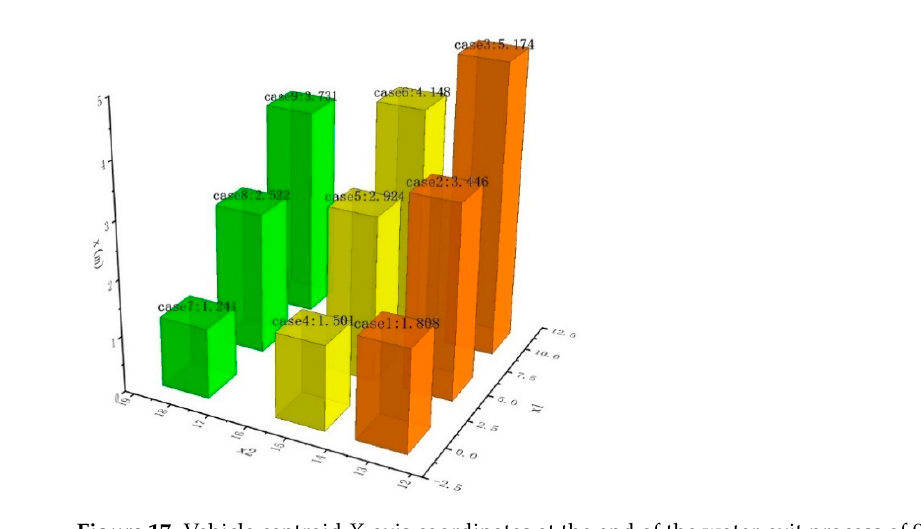
Figure 16. Centroid coordinates of vehicle in case 3, 6, 9. ( a ) Vehicle centroid X -axis coordinates. ( b ) Vehicle centroid Y -axis Coordinates. ( c ) Vehicle centroid Z -axis coordinates.